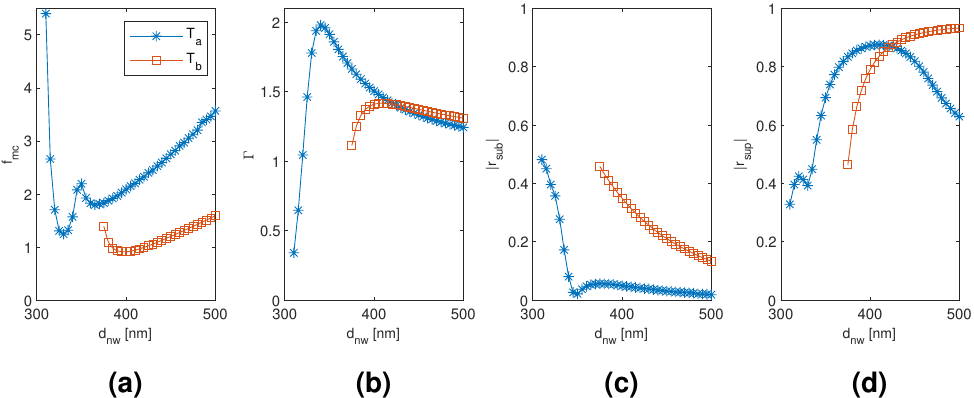
Figure 7. The results for the tetramer T a and T b mode as a function of the diameter of the nanowires with the separation of the nanowires corresponding to the point of modal cost function minimum for each mode (as listed in Table 1). ( a ) modal cost function value; ( b ) modal confinement factor; ( c ) substrate modal reflection coefficient magnitude; ( d ) superstrate modal reflection coefficient magnitude.